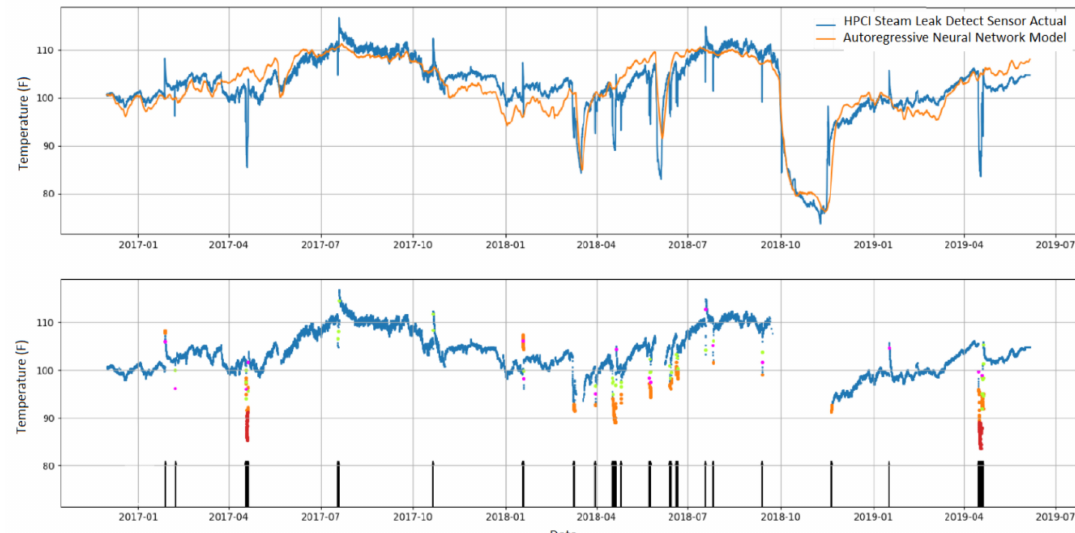
Figure 7. Results of the autoregressive method for anomaly detection (The top plot shows the actual steam leak sensor data [blue] and the estimated HPCI room temperature generated by the recurrent neural network [orange], while the bottom plot shows the clustering results as they corre- spond in